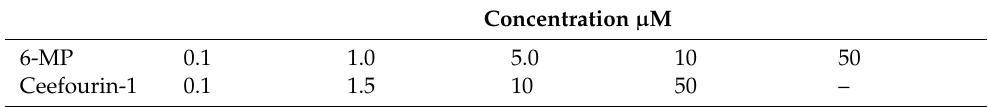
Table 1. Concentrations of both 6-MP and ceefourin-1 for the proliferation and viability assays. Concentration µ